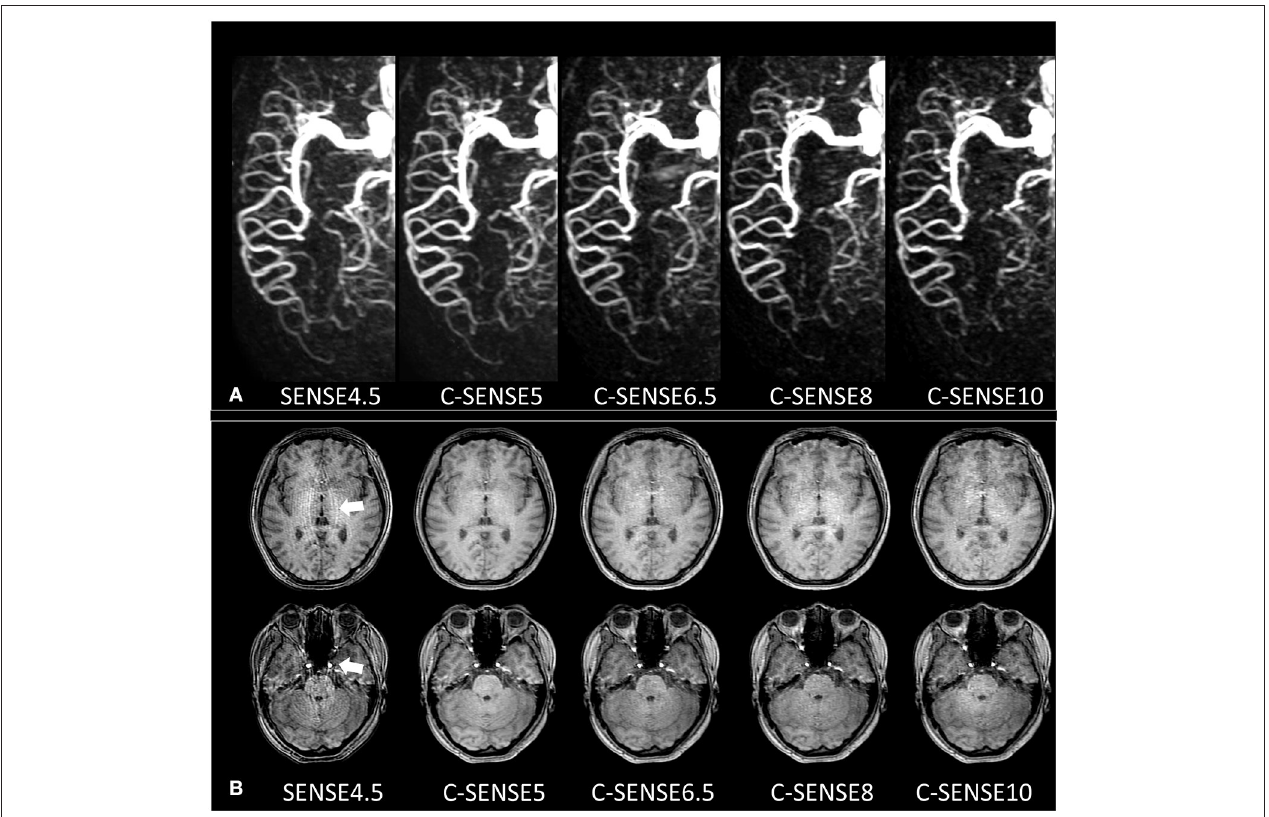
FIGURE 1 | (A) 4D-PACK images with different acceleration factors in a 32-year-old woman. The M1, M2, and M3 segments of the MCA had 4 scores in all sequences and had sharp vessel margins with confident diagnosis. The M4 segment in SENSE4.5 and C-SENSE5 had 3 scores, which indicated a slightly vague vessel margin but resulted in a confident diagnosis. The M4 segment in C-SENSE6.5 and C-SENSE8 had 2 scores, which indicated heavily blurred vessel margins with no confident diagnosis. The M4 segment in C-SENSE10 had a score of 1 because some vessels disappeared. (B) Source images of 4D-PACK combined with different acceleration factors. SENSE4.5 and C-SENSE10 acquisitions (3 scores) had moderate artifacts; there were almost no artifacts in C-SENSE5 acquisition (5 scores), and there were a few artifacts when C-SENSE6.5 and C-SENSE8 (4 scores) were